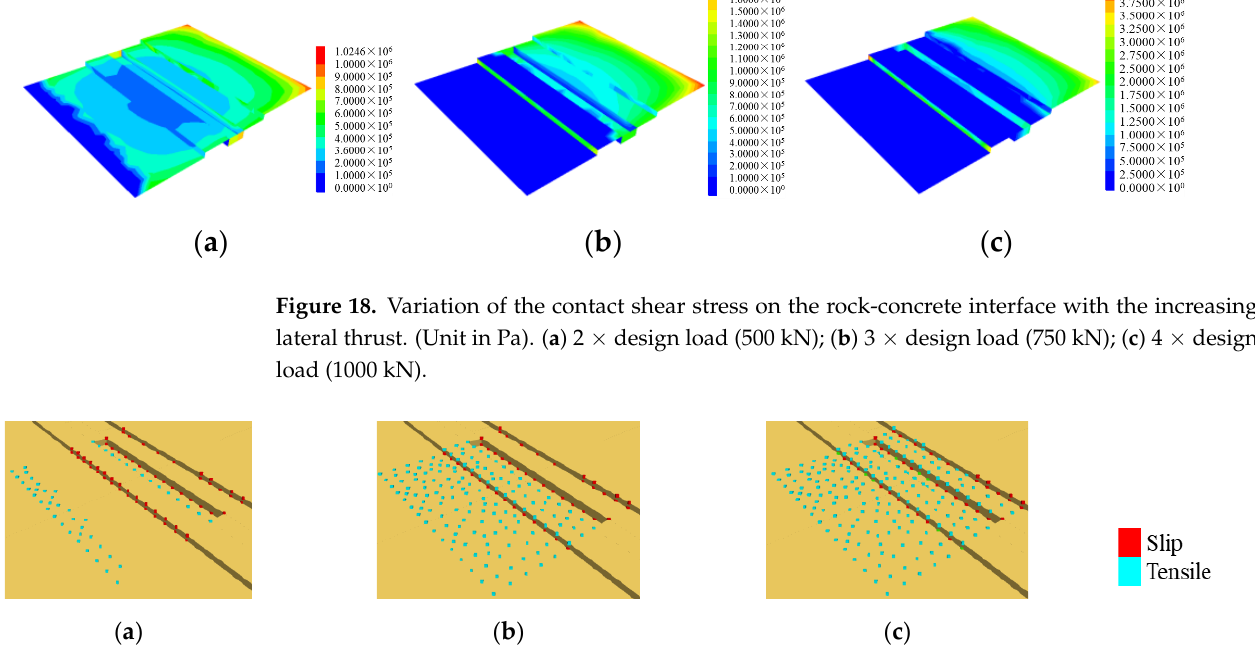
Figure 19. Variation of yield state of the rock-concrete interface with the increasing lateral thrust. ( a ) 2 × design load (500 kN); ( b ) 3 × design load (750 kN); ( c ) 4 × design load (1000 kN).